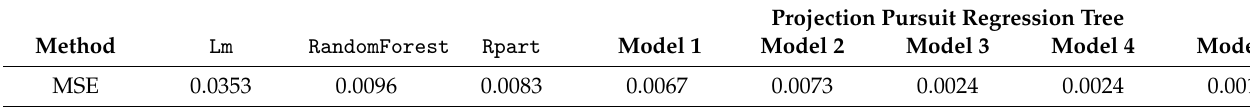
Table 3. MSEs of lm , randomForest , rpart , and the projection pursuit regression tree.